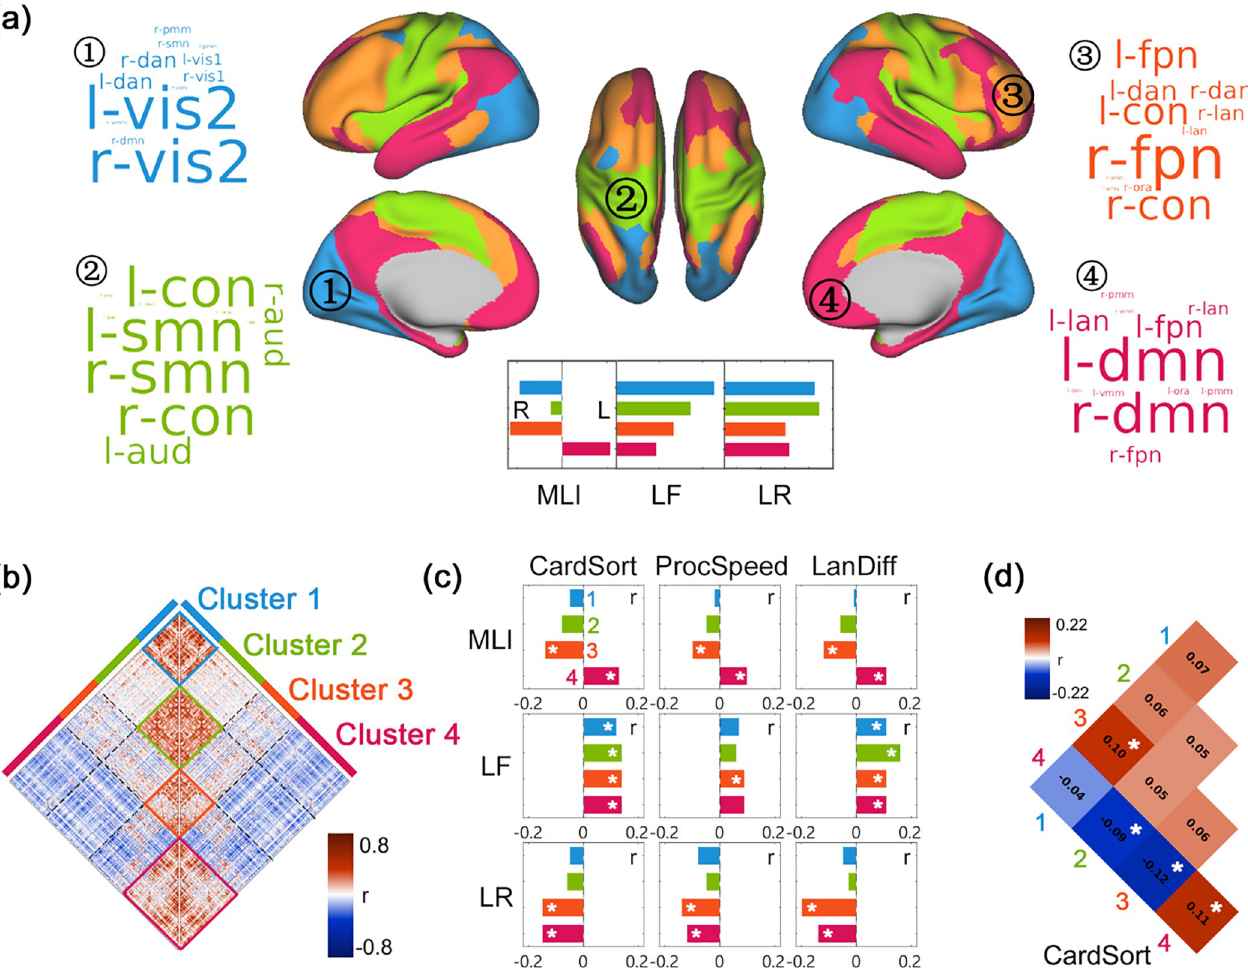
Fig 3. Spatial clustering of laterality dynamics. (a) Four spatial clusters revealed by clustering of the laterality time series of all 360 brain regions. The word cloud for each cluster indicates the functional networks being involved (based on the CAB-NP), with the font size representing the proportion of each network in the cluster. L, left-lateralized; R, right-lateralized; MLI, mean laterality index; LF, laterality fluctuations; LR, laterality reversal. The mean value of the 3 dynamic laterality measures of the 4 spatial clusters are shown in the inset. (b) The laterality correlation matrix across 360 brain regions (averaged over all 991 participants). (c) The correlation between the 3 dynamic laterality measures (MLI, LF, LR) of the 4 spatial clusters and cognitive performance of 3 tasks. CardSort, the performance of Dimensional Change Card Sort Test; ProcSpeed, the performance of Pattern Comparison Processing Speed Test; LanDiff, mean difficulty of stories for each participant in HCP language task. (d) The association between the laterality correlation within/between clusters and the processing speed (Pattern Comparison Processing Speed Test). Only significant results (Pearson correlation, FDR corrected, FDR q < 0.05, marked by one asterisk � ) are shown. The underlying data for this figure can be found in S4 Data. CAB-NP, Cole-Anticevic Brain-wide Network Partition; FDR, false discovery rate; HCP, Human Connectome